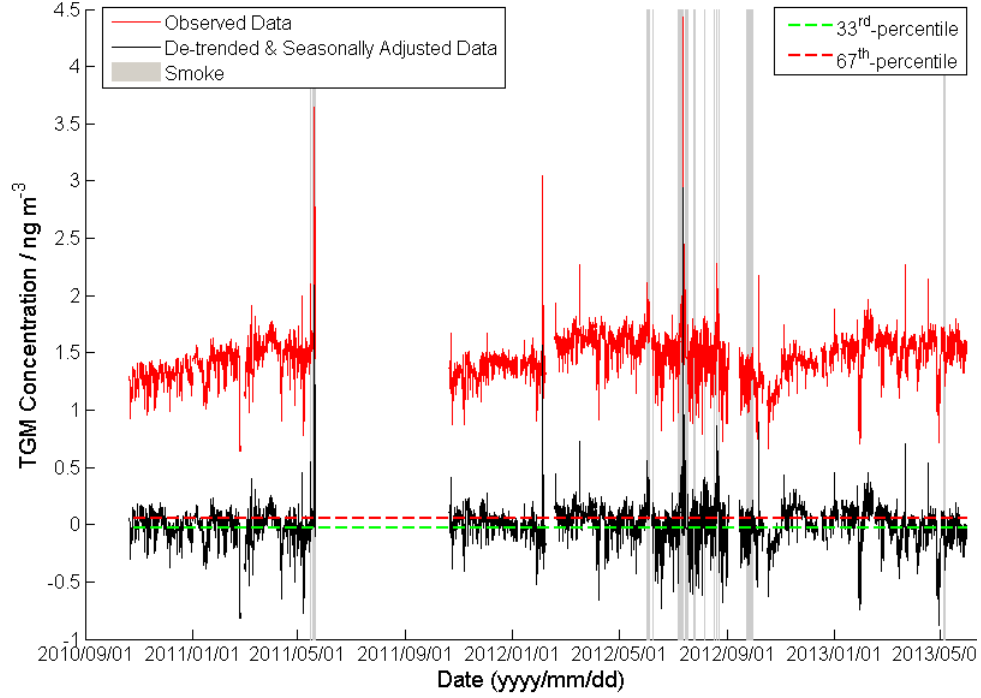
Figure 1. Time series of hourly total gaseous mercury (TGM) concentrations at Patricia McInnes station. Grey shaded areas indicate when forest fire smoke was in the vicinity of the monitoring station. The de-trended/seasonally adjusted TGM time series is shown for reference. As described in the text, TGM concentration data was categorized as “high”, “average”, or “low”, with divisions at the 33rd- and 67th-percentiles in de-trended/seasonally adjusted TGM